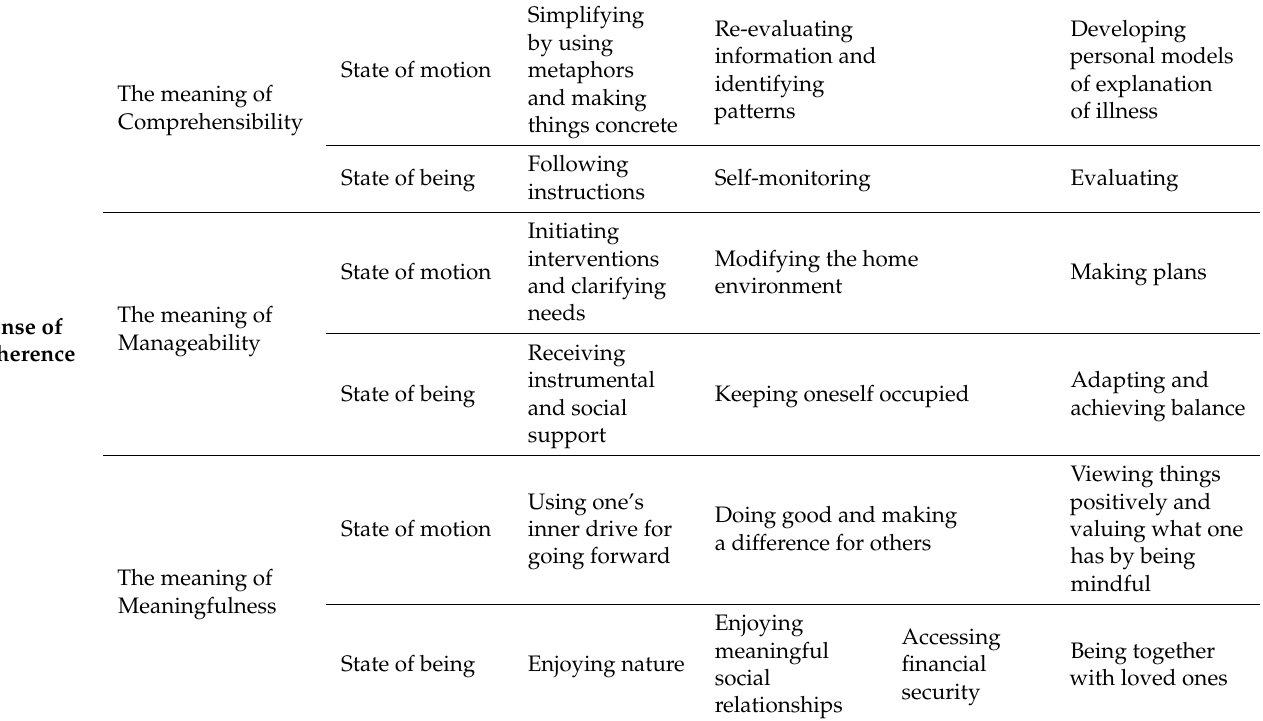
Table 2. An overview of the meaning of Sense of Coherence in persons with Late Effects of